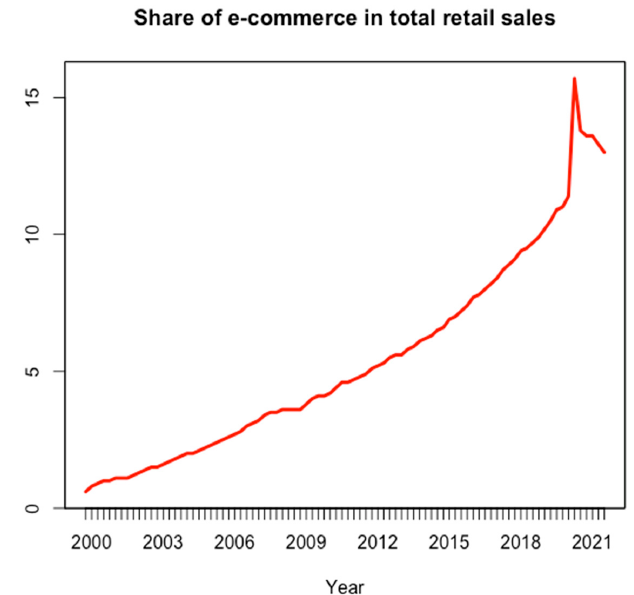
Figure 3. Quarterly evolution of the share of E-Commerce in Total Retail Sales [ECOMPCTSA] over 1999–2021, Author’s representation with data retrieved from the Federal Reserve Bank of St. Louis (FRED), which sources data from U.S. Census Bureau; https://fred.stlouisfed.org/series/ECOMPCTSA, accessed on 8 September 2022.